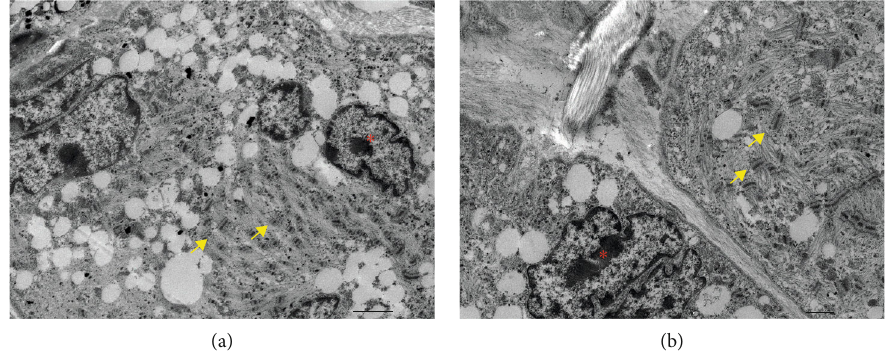
Figure 3: (a, b) Electron microscopy of those small cells reveals multiple nuclei with prominent nucleoli (red asterisks) and myo fi brils (yellow arrows). Scale bar is 2 μ M and 1 μ M for (a, b),